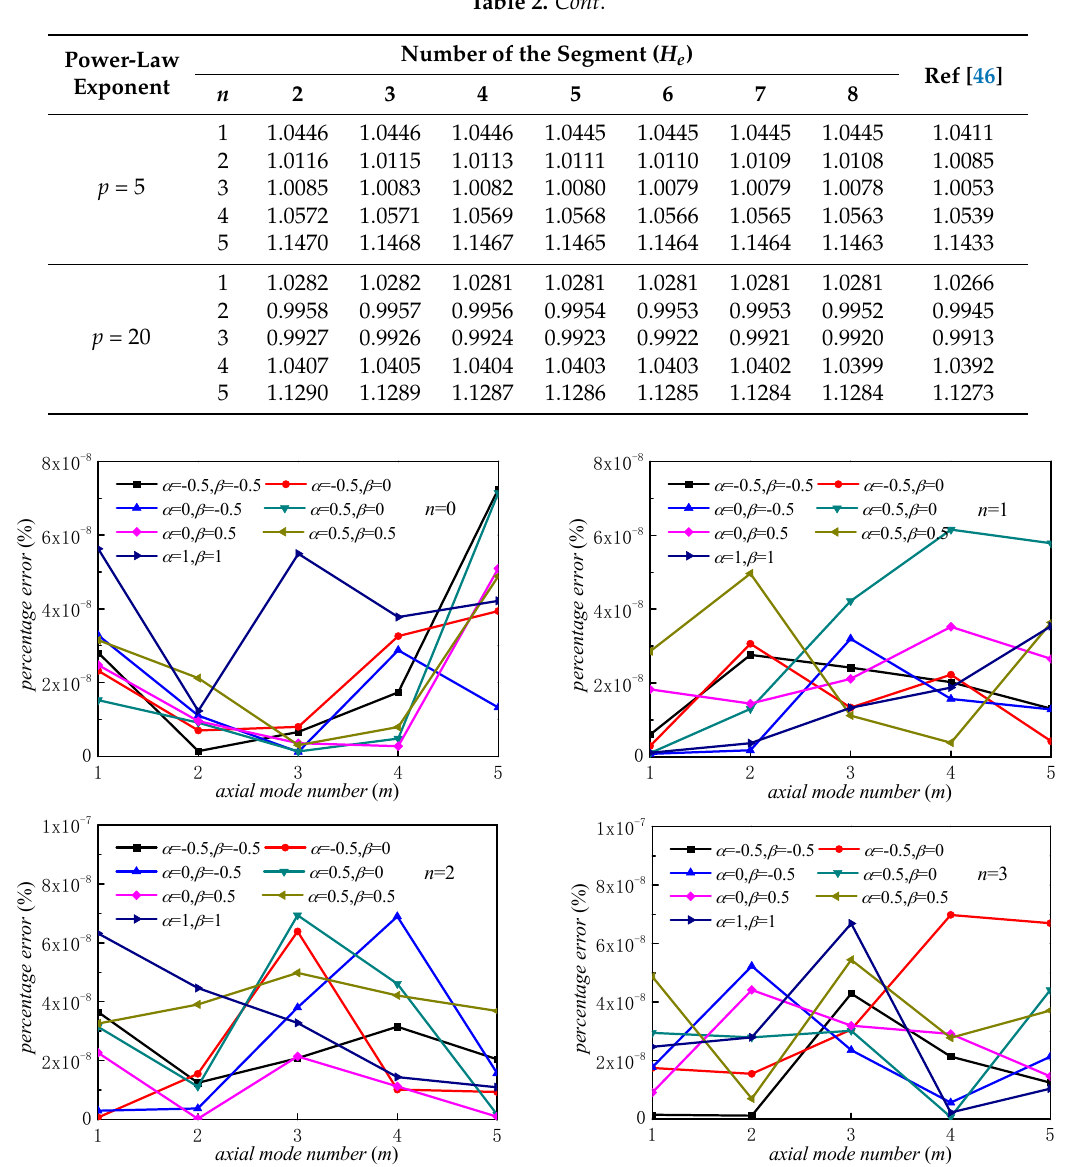
Figure 5. Relative error of frequency parameters Ω in stepped FG paraboloidal shell (BC: C–C).